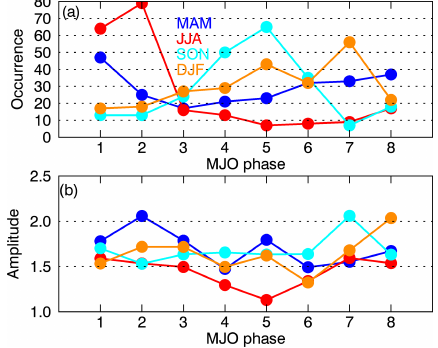
Figure 11. A statistical summary of strong MJO phases with ampli- tude > 1 from 2007 to